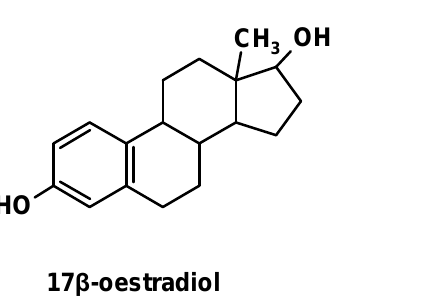
Figure 1. The structures of 17 β -estradiol and